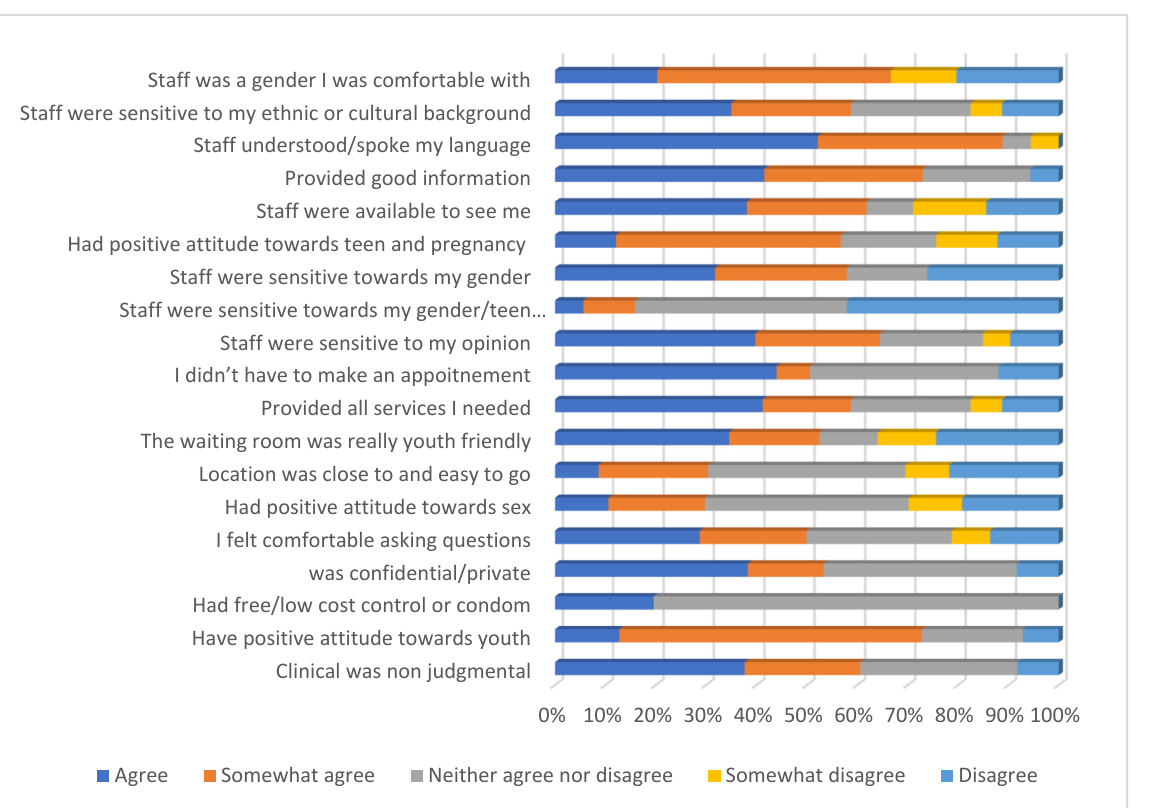
Figure 3. Adolescents’ Experiences of Adolescent-Friendly Sexual and Reproductive Health Service.